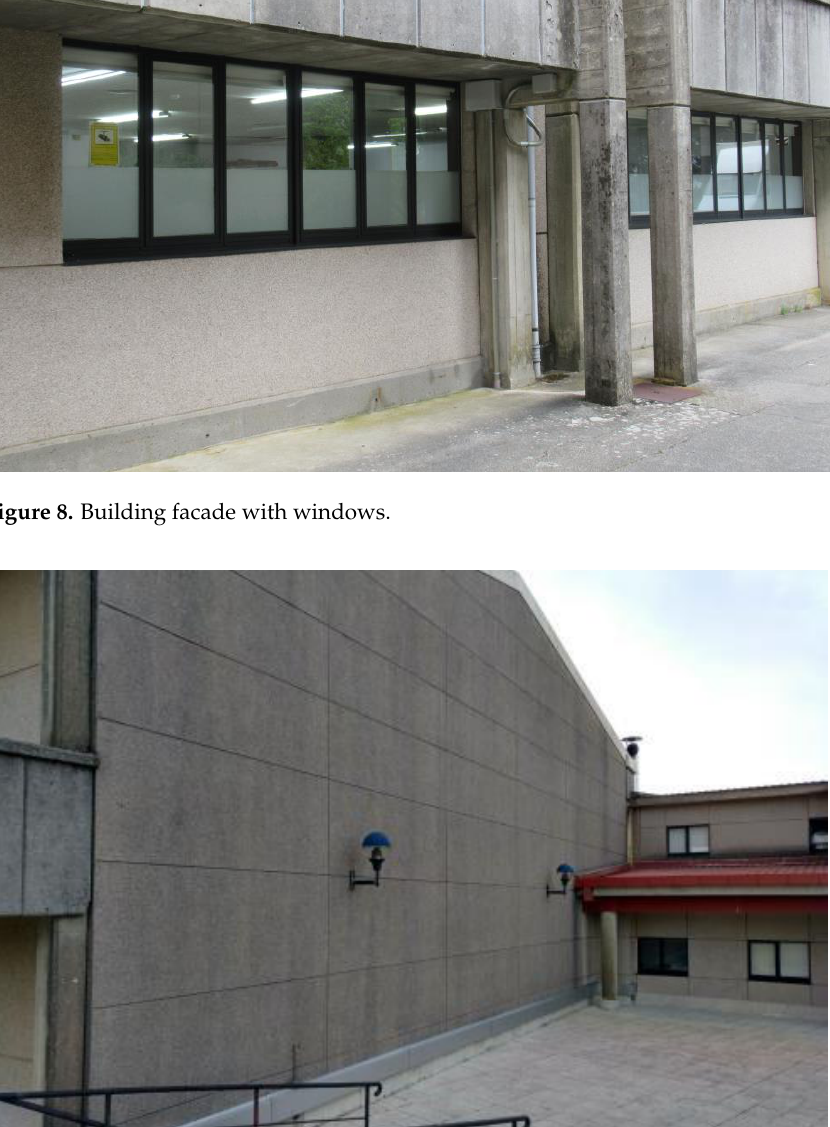
Figure 9. Building facade with no